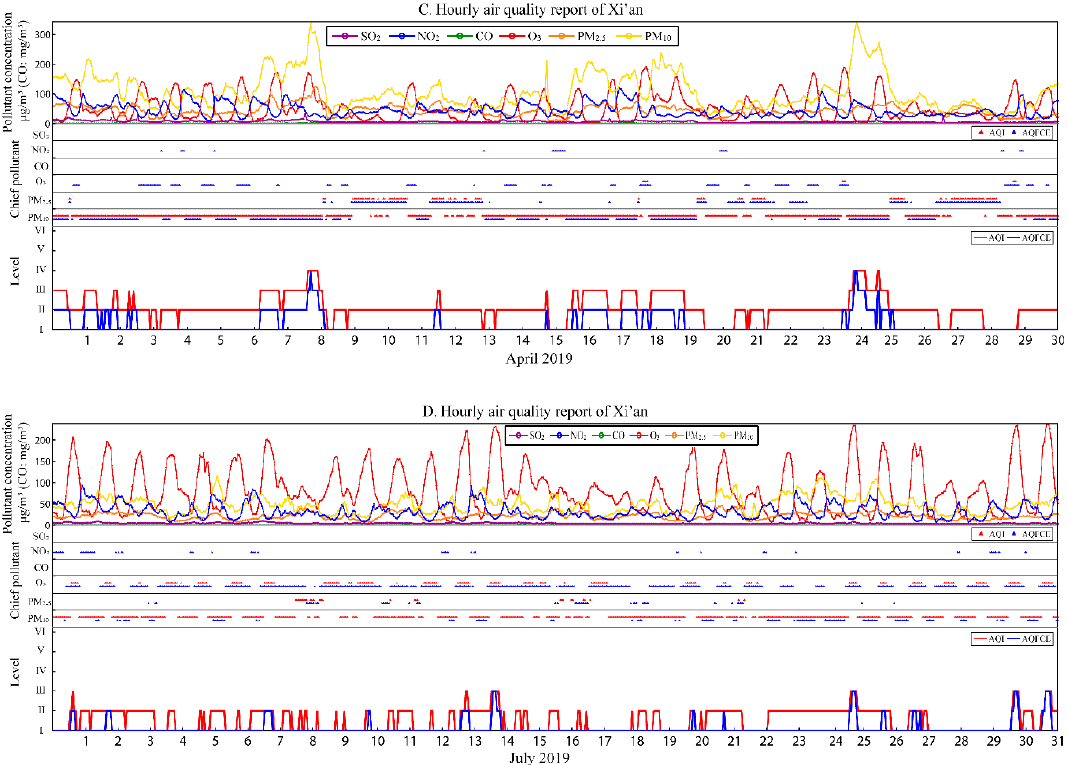
Figure 8. Hourly pollutant concentration variation and air quality evaluation result of chief pollutant and level of Xi’an. Table 5. The comparison of evaluation result between the Air Quality Index (AQI) and Air Quality Fuzzy Comprehensive Evaluation (AQFCE) by consistent rate (CR) (T). Beijing